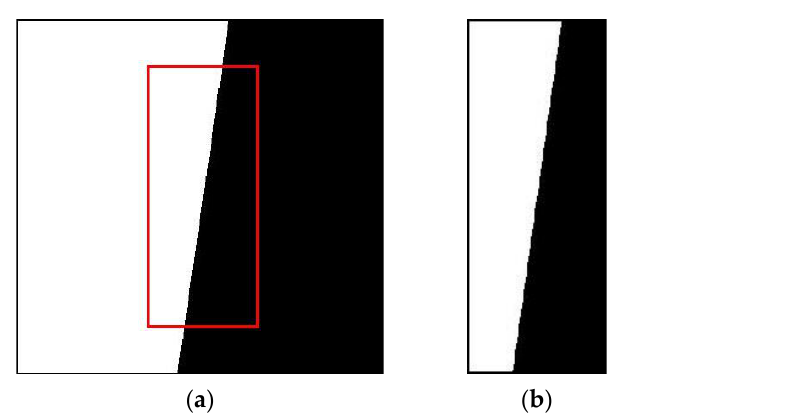
Figure 9. Ideal edge image and ROI: ( a )the ideal edge image; ( b )the ROI intercepted from Figure 9a.